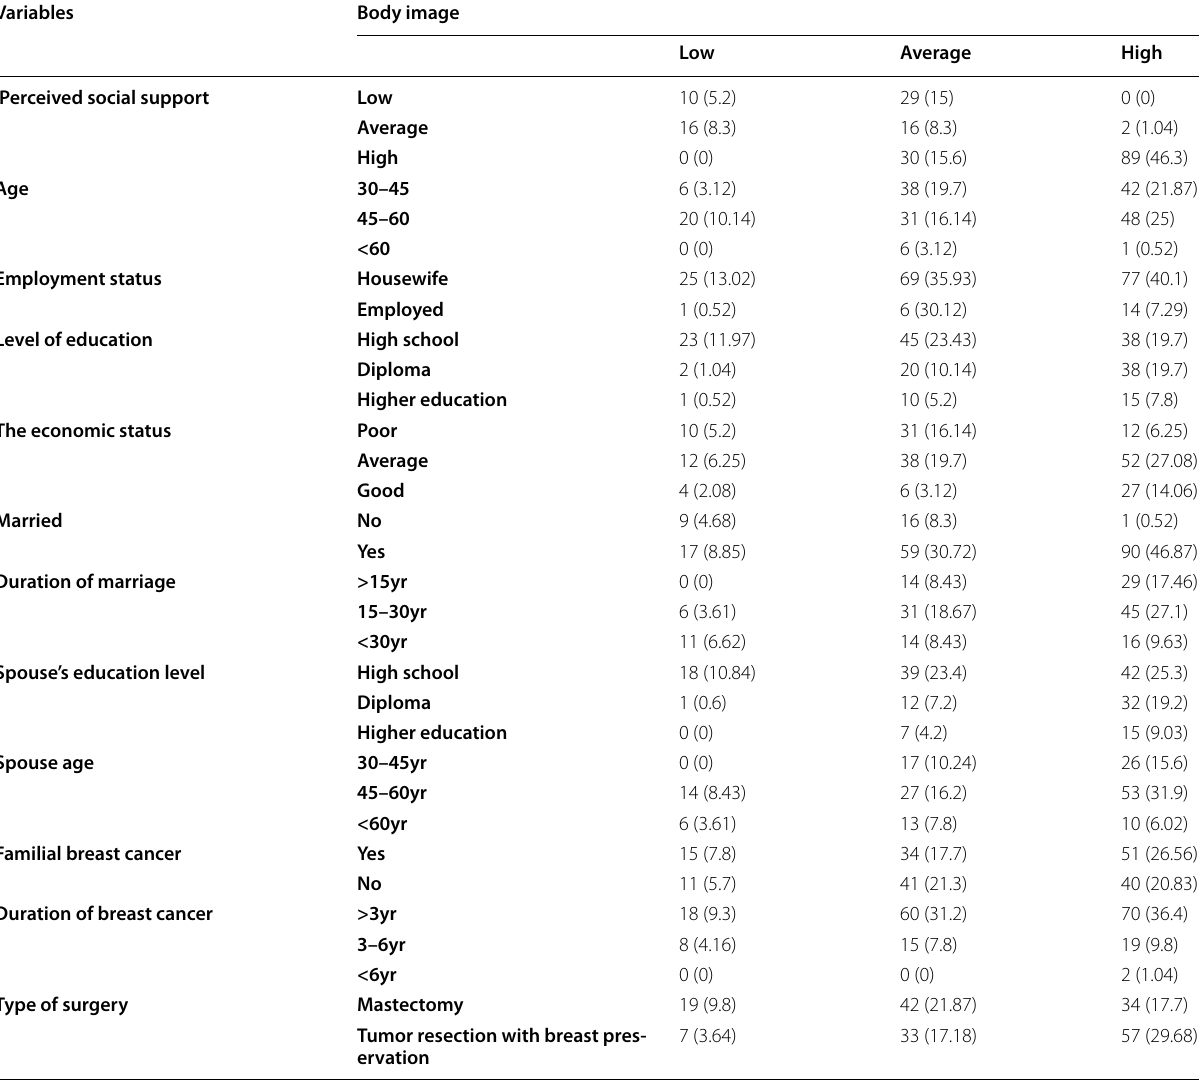
Table 1 Frequency distribution (percentage) of research units according to perceived levels of social support and demographic variables with levels of body image in women with breast cancer referred to the accelerator ward of Golestan Hospital in Ahvaz